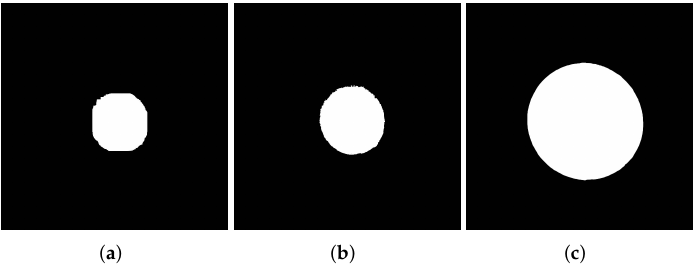
Figure 7. Circle extraction. ( a ) First circle partially extracted after erosion operation. ( b ) First circle completely reconstructed. ( c ) Second circle extracted.